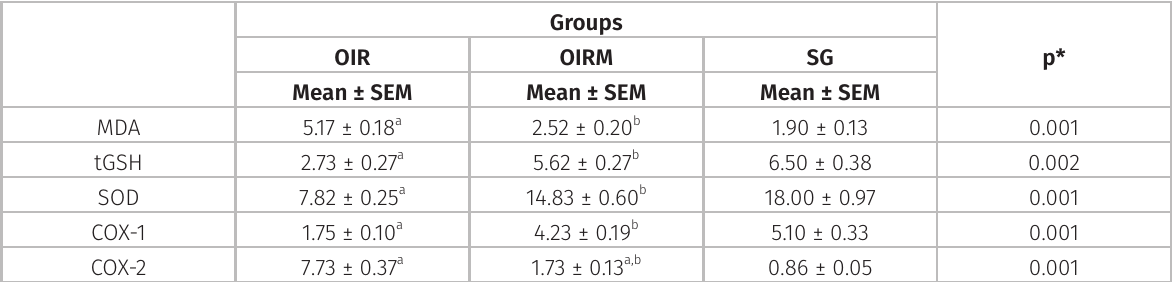
Table I. Descriptive statistics of biochemical results in study groups.